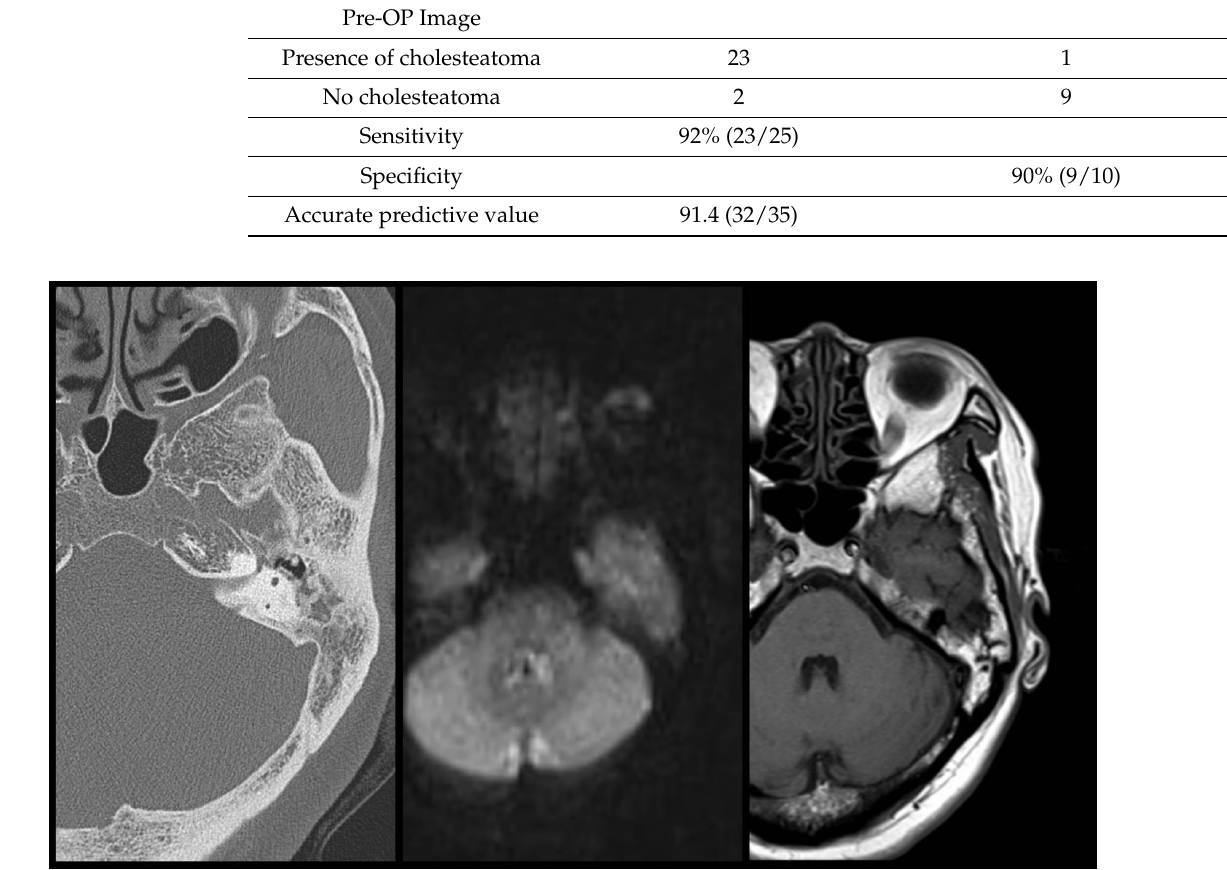
Figure 3. DW-T1W-CT images of false negative case (case 25). From left to right, CT-DWI-T1. Figure 1. DW-T1W-CT images of false positive case (case 26). From left to right, CT-DWI-T1.